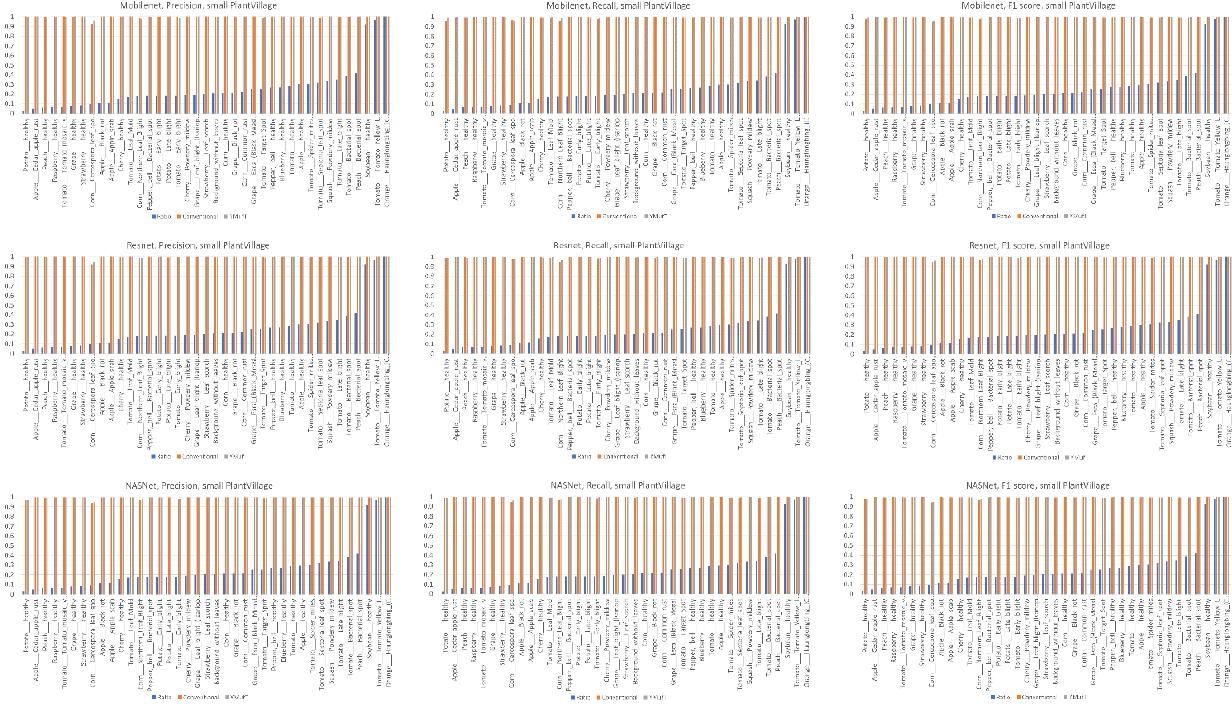
Figure 19. Precision, recall, and F1 score on each class in the small PlantVillage dataset. The blue bars indicate the ratio of the number of samples of a class to the maximum number of samples in all classes.